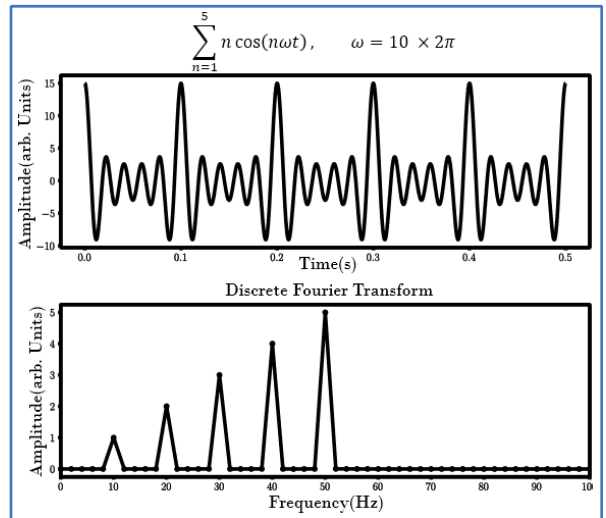
Figure 4. An example of Fast Fourier Transform.